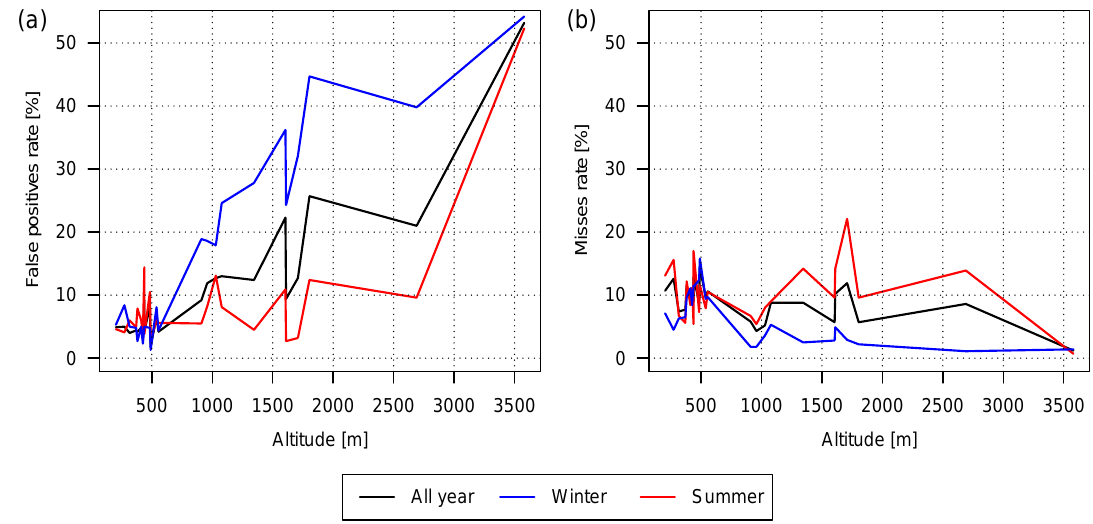
Figure 4. MODIS-Aqua cloud mask compared to 24 SYNOP stations in Switzerland. The SYNOP–MODIS overlap varies from one station to another, from 3.3 years to the whole MODIS record (12 years). The satellite mask false positives (a) correspond to when the satellite data set contains a cloud, but the ground observer reports a value of less than 4 oktas of clouds. The misses (b) are the opposite disagreement between the